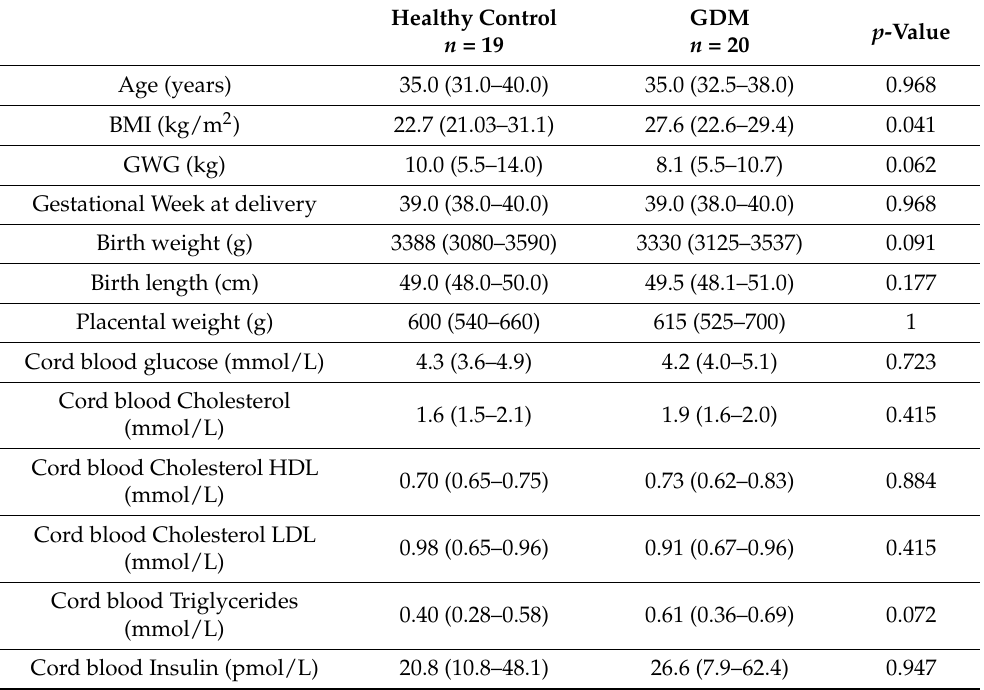
Table 2. Characteristics of the cohort included in the placental expression